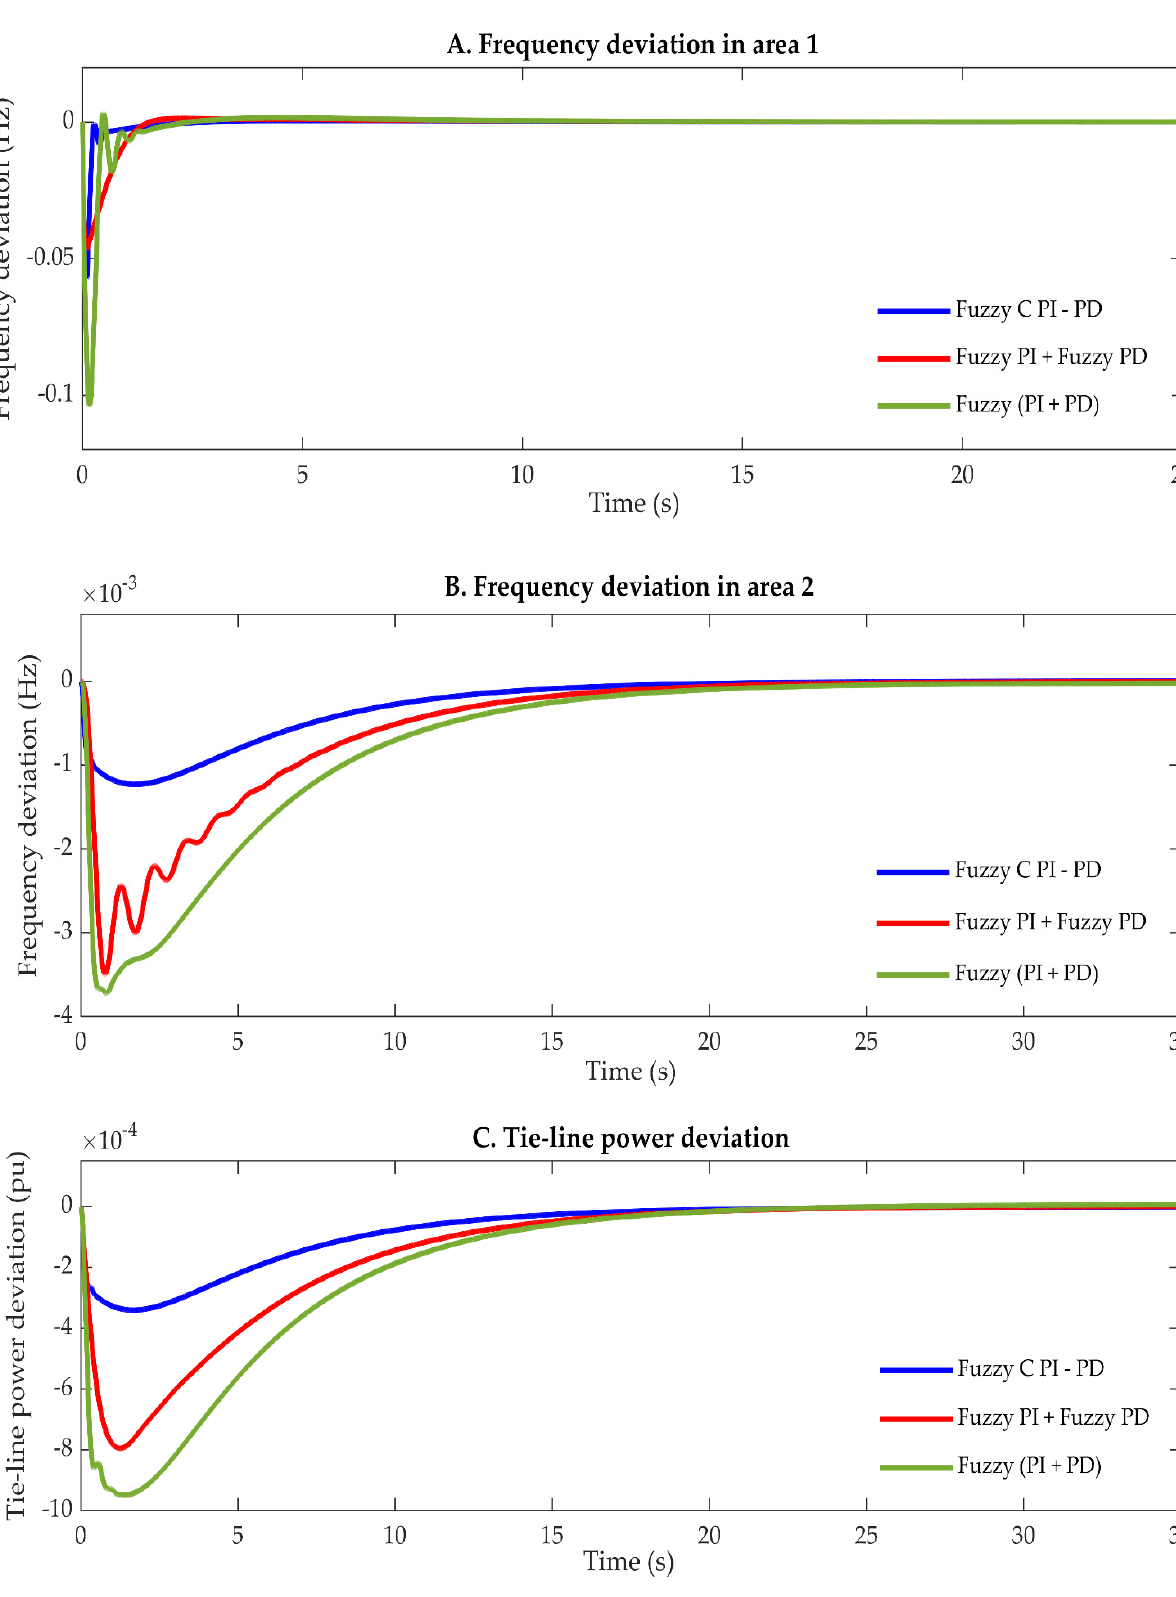
Figure 30. Dynamic response of the testbed power system based on different fuzzy controllers under parametric uncertainty conditions, case 9. ( A ) Frequency variation in area 1; ( B ) frequency variation in area 2; ( C ) tie-line power variation.